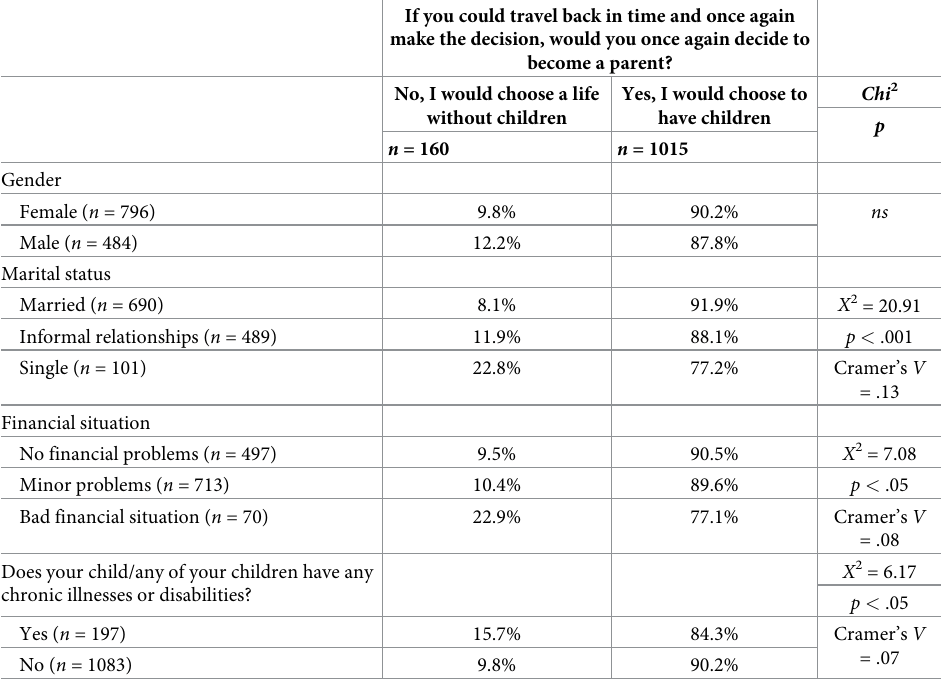
Social and demographic factors in parents regretting parenthood. As in Study 1, no sig- nificant differences in respect of the frequency of regretting parenthood could be observed between women and men (Table 9); as in Study 1, it turned out that significant differences could be observed between parents with different marital statuses, Chi 2 (2) = 20.91, p < .001, Cramer’s V = .13: among the individuals who were married, 8.1% regretted having children; among the individuals in informal relationships, the proportion was 11.9%; and among the single parents it was 22.8%. As in Study 1, differences could also be spotted between the indi- viduals with different assessments of their financial situation, Chi 2 (2) = 11.71, p < .01, Cra- mer’s V = .10: among the participants who claimed that they did not have financial difficulties, 9.5% regretted parenthood, among the individuals with minor financial difficulties the figure was 10.4%, and among the parents with serious financial problems, the percentage who regret- ted having children was 22.9%. Also, a relationship could be observed–not too strong, although significant–between having a child with special needs and regretting parenthood, Chi 2 (1) = 5.20, p < .05, Cramer’s V = .06. Among the parents who had at least one child with special health needs, the percentage of those who regretted parenthood was 15.7%, whereas, among the parents whose children had no such health issues, this percentage was 9.8%. Among the individuals bringing up a child with special needs, no relationship between regretting parent- hood and the level of the child’s health problems could be observed, F (1,252) = 3.18, p = .076, eta 2 = .01. Table 9. Regretting parenthood and gender, marital status, and financial situation (Study 2). If you could travel back in time and once again make the decision, would you once again decide to become a parent? No, I would choose a life Yes, I would choose to Chi 2 without children have children p n = 160 n = 1015 Gender Female ( n = 796) 9.8% 90.2% ns Male ( n = 484) 12.2% 87.8% Marital status Married ( n = 690) 8.1% 91.9% X 2 = 20.91 Informal relationships ( n = 489) 11.9% 88.1% p < .001 Single ( n = 101) 22.8% 77.2% Cramer’s V = .13 Financial situation No financial problems ( n = 497) 9.5% 90.5% X 2 = 7.08 Minor problems ( n = 713) 10.4% 89.6% p < .05 Bad financial situation ( n = 70) 22.9% 77.1% Cramer’s V = .08 Does your child/any of your children have any X 2 = 6.17 chronic illnesses or disabilities? p < .05 Yes ( n = 197) 15.7% 84.3% Cramer’s V = .07 No ( n = 1083) 9.8%